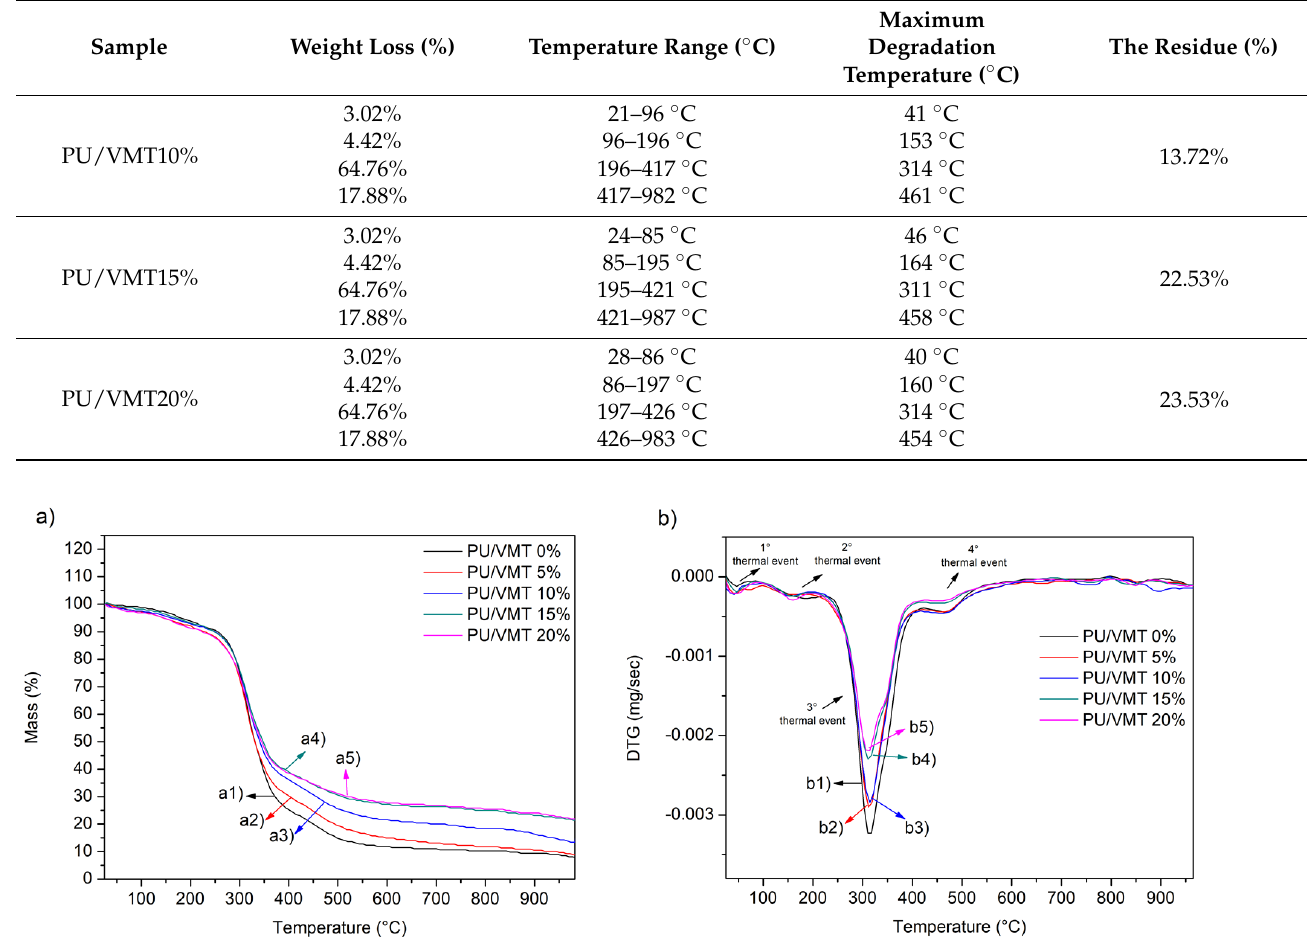
Figure 2. ( a ) TG curves of the composites: PU/VMT 0% (a1), PU/VMT 5% (a2), PU/VMT 10% (a3),